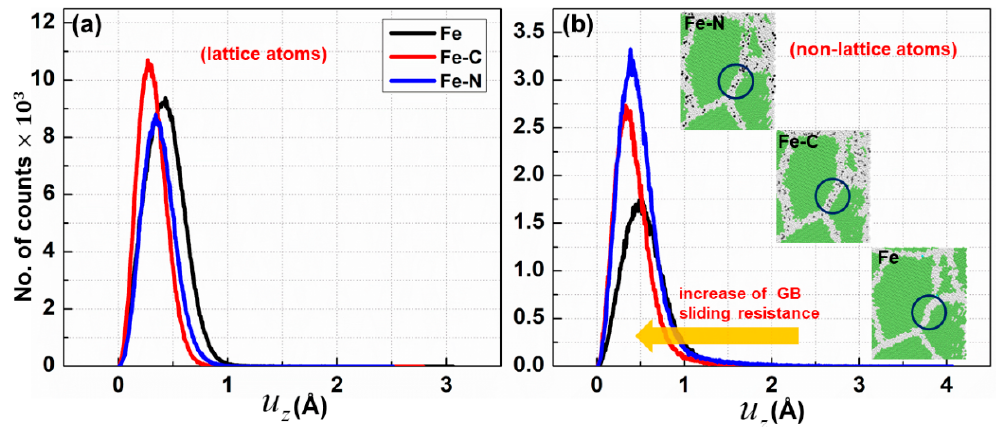
Figure 7. Distribution of atomic-level displacement ( u z ) for di ff erent nc samples at 2% strain ( a ) grain interior atoms (lattice atoms), ( b ) grain boundary atoms (non-lattice). The circles denote GBs that were investigated.